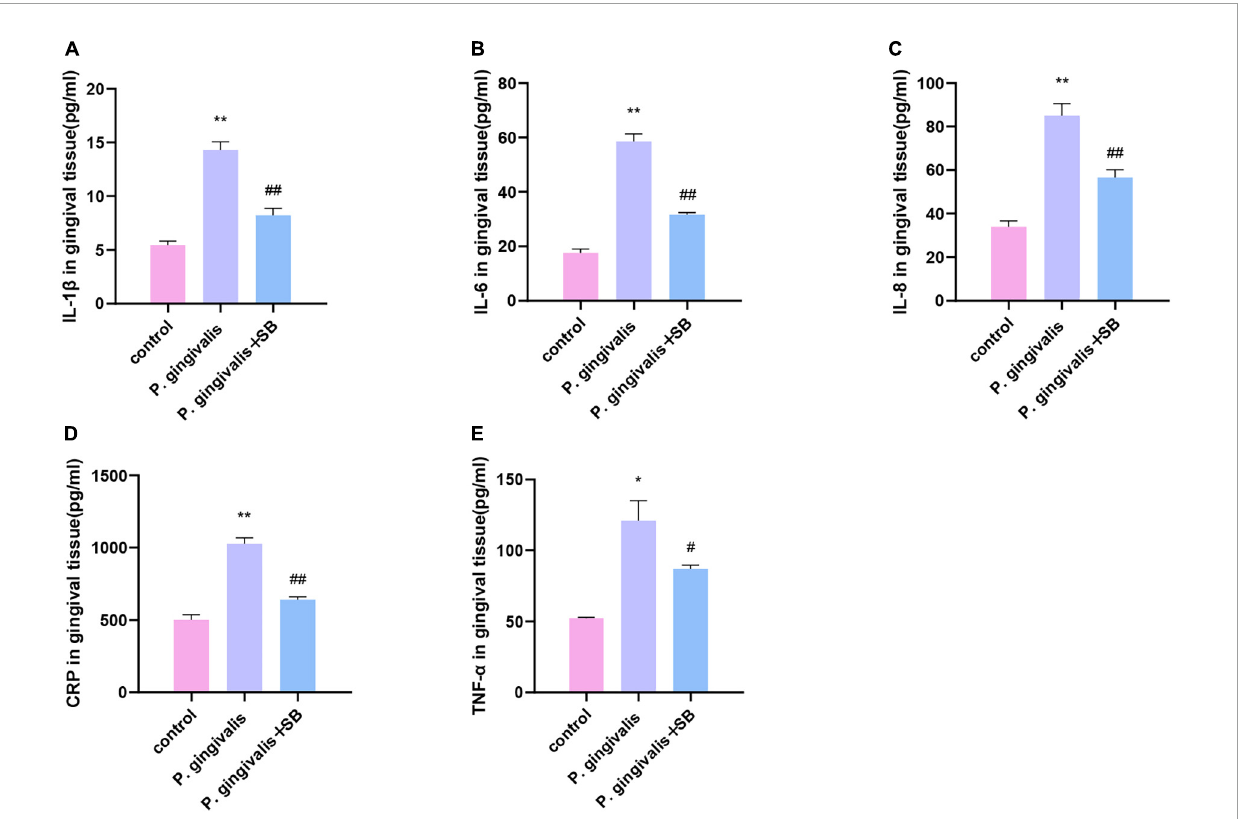
FIGURE5 Effects of periodontal inflammation in the gingival tissue. ELISAs were performed to detect the protein levels of inflammatory cytokines. (A) IL-1 β ; (B) IL-6; (C) IL-8; (D) CRP; (E) TNF- α . Experimental values are expressed as the mean ± SEM ( n = 4 per group). * p < 0.05 and ** p < 0.01 compared with the control group, # p < 0.05 and ## p < 0.01 compared with the P. gingivalis group.